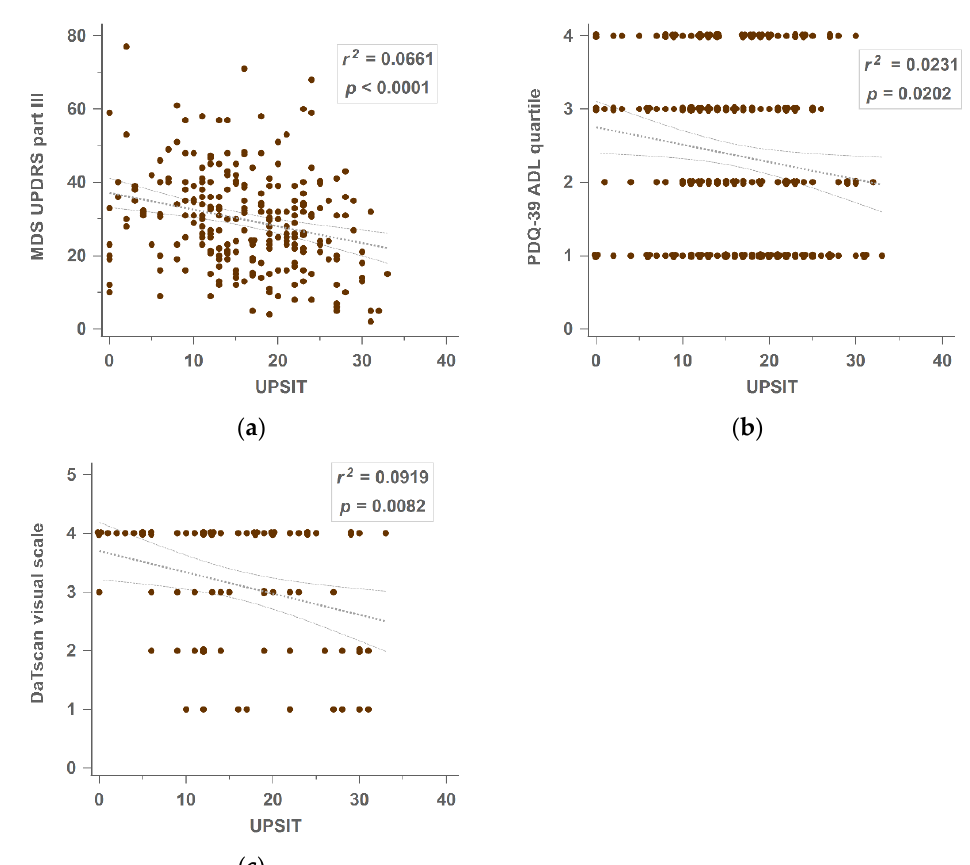
Figure 1. Linear regression of ( a ) MDS UPDRS part III on UPSIT, n = 234; ( b ) PDQ-39 ADL